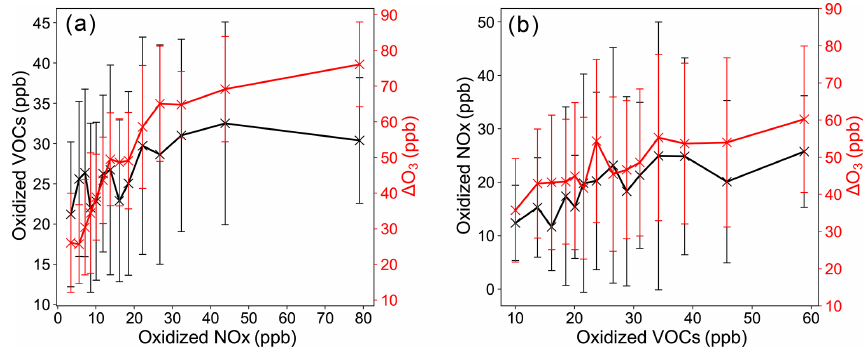
Figure 6. Ozone formation rate ( (cid:49) O 3 , right-hand side in red) and the oxidized VOC (left-hand side in black) plotted as a function of oxidized NO x (a) . Ozone formation rate ( (cid:49) O 3 , right-hand side in red) and oxidized NO x (left-hand side in black) plotted as a function of the oxidized VOC (b) .